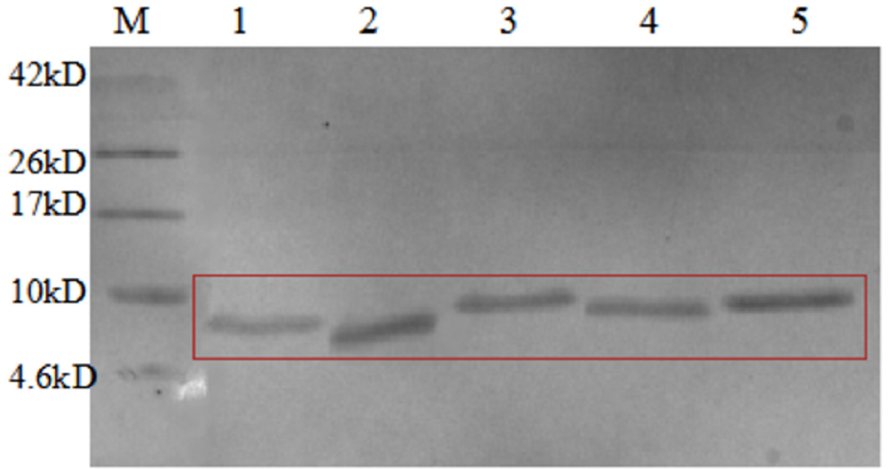
Figure 6. Tricine SDS-PAGE analysis of AMP purification. Lane 1-5, the purified AMP 1, 2, 6, 13 and 16.